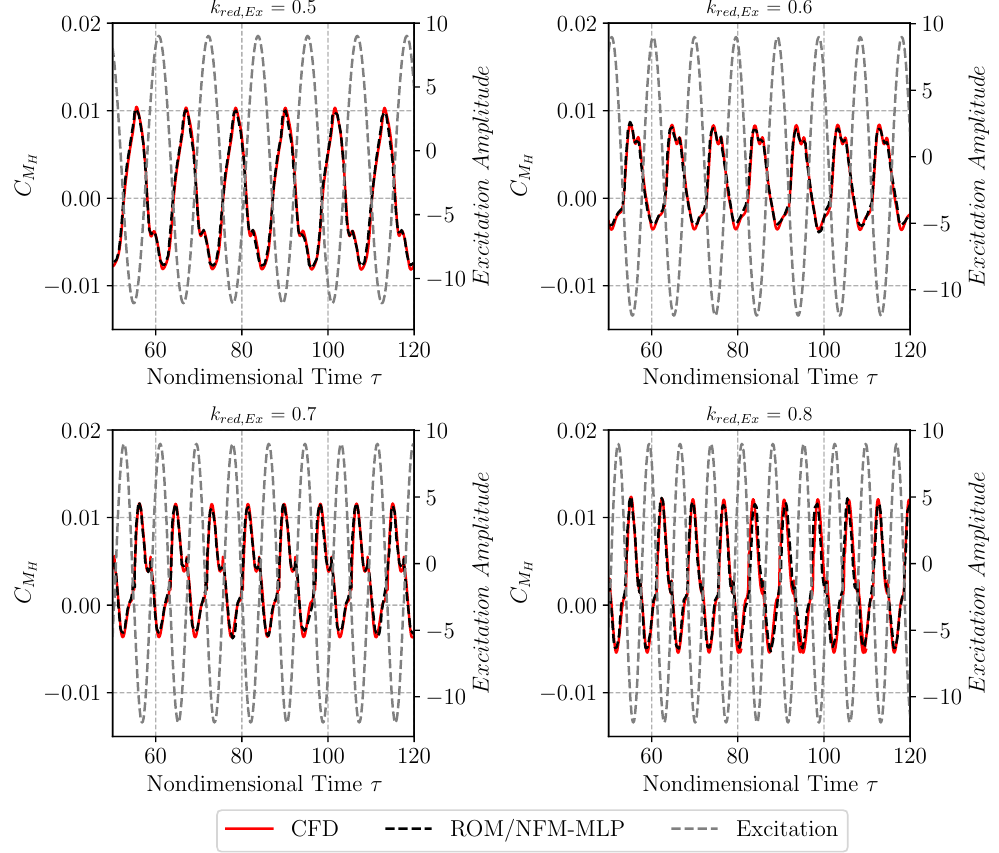
Figure 8. Responses of the hinge moment coefficient resulting from harmonic aileron pitching motion with k red , Ex = [0.5, 0.6, 0.7, 0.8]. The results of the NFM-MLP ROM are compared to the reference CFD solution (NACA65 1 213 airfoil, Ma ∞ = 0.82, Re = 20.7